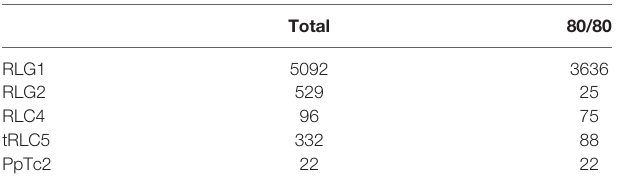
TABLE 1 | Total number of complete elements (total), number of elements showing 80% identity over 80% of the length of the corresponding RNA assembly (80/80) for each indicated TE family.